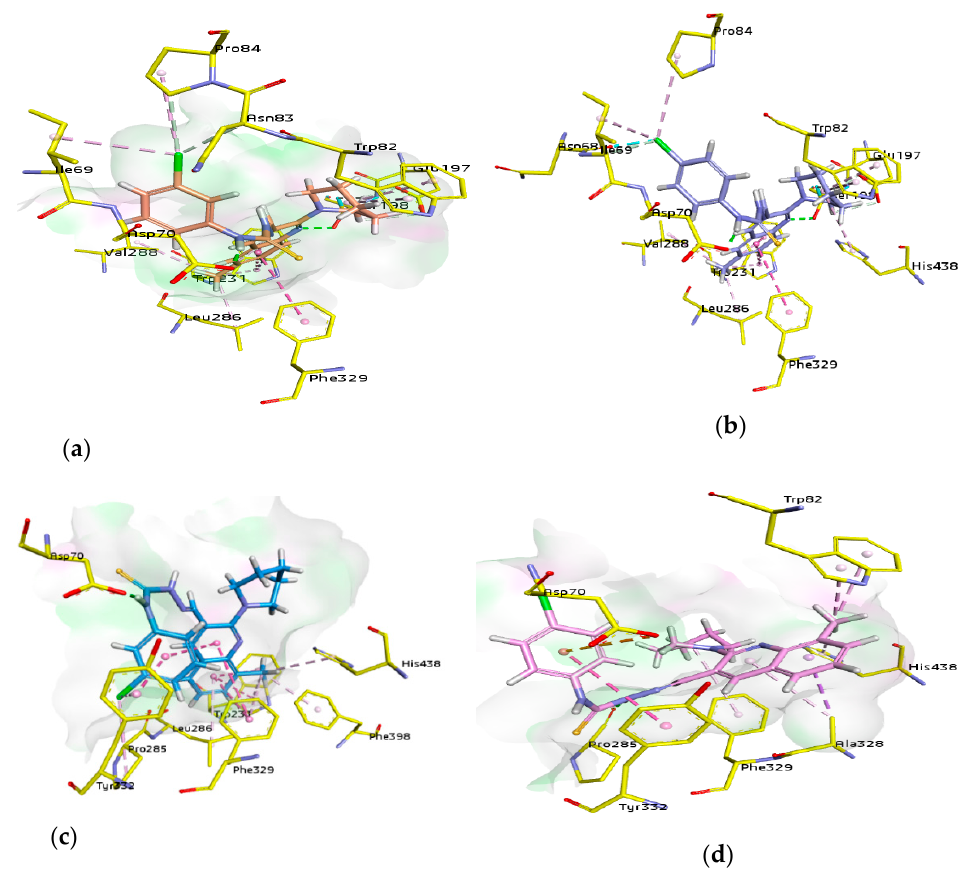
Figure 9. 3D binding modes of 5f ( a ), 5g ( b ), 6f ( c ), and 6g ( d ) with the amino acid residue of BChE, hydrogen bonding is shown by green dashed line, hydrophobic interactions are shown by light purple color, dark pink dashed lines show π -T shaped, light pink color shows π - π stacked interactions, and purple color dashed lines show π -sigma type interactions. Table 2. Docking score of the top pose of selected compounds and their ranks after HYDE visual inspection in the AChE and BChE.